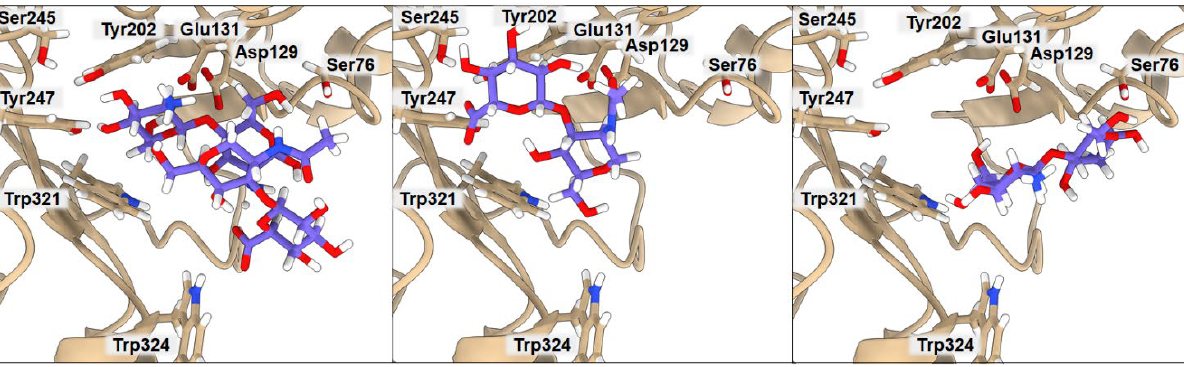
Figure 2. Ribbon representation of YKL-39 with docked CHI/FUR, CHI, FUR, and GlcNAc 2 saccha- rides, respectively. Key amino acids that create interactions with ligands are marked in black.